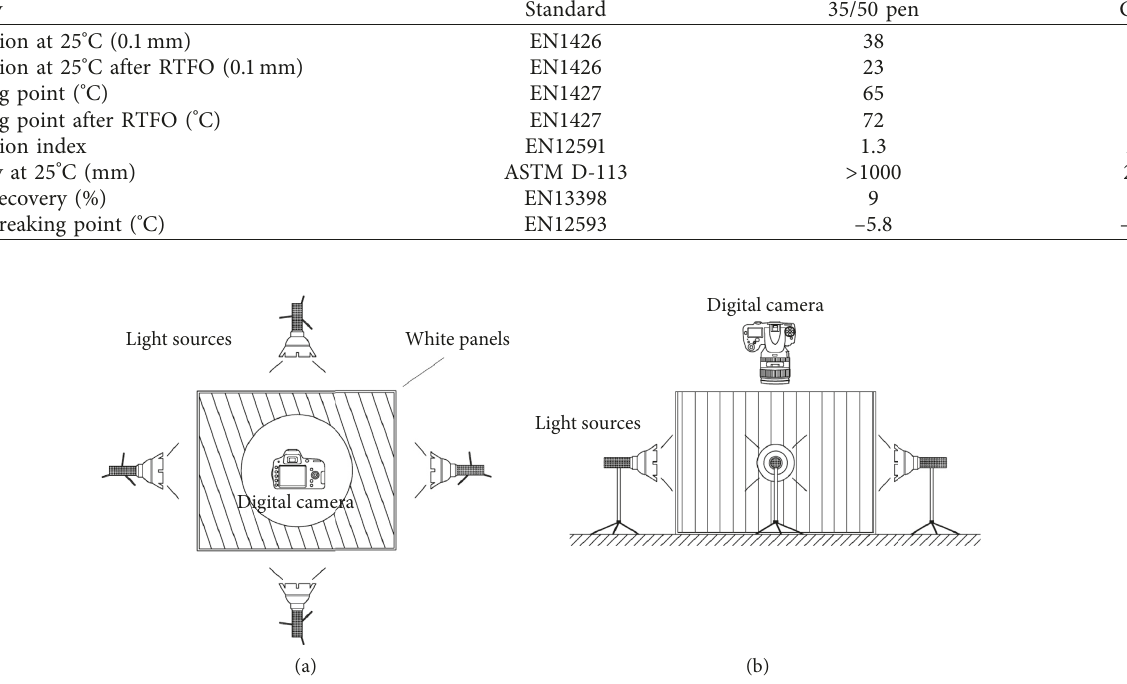
Figure 1: Confined chamber for image acquisition: top (a) and side (b)